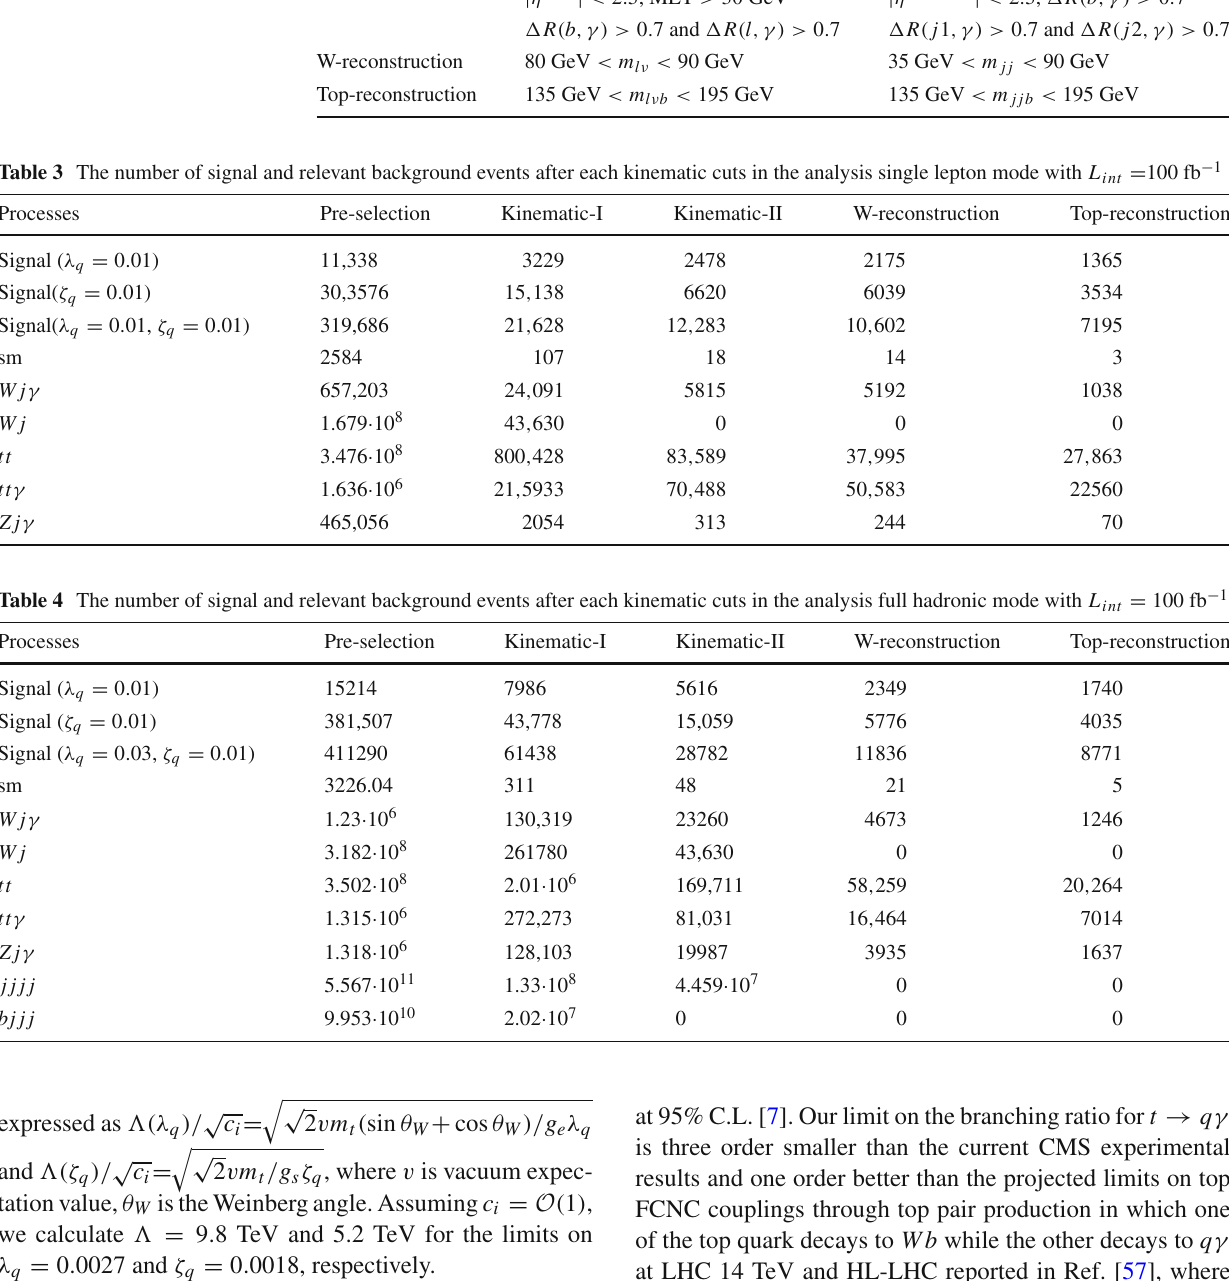
Table 2 Event selection and kinematic cuts used for the analysis of signal and background events in hadronic and leptonic channels